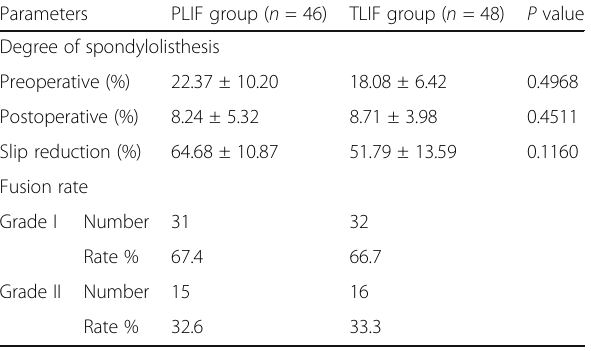
Table 3 Slip reduction and fusion rate of spondylolisthesis